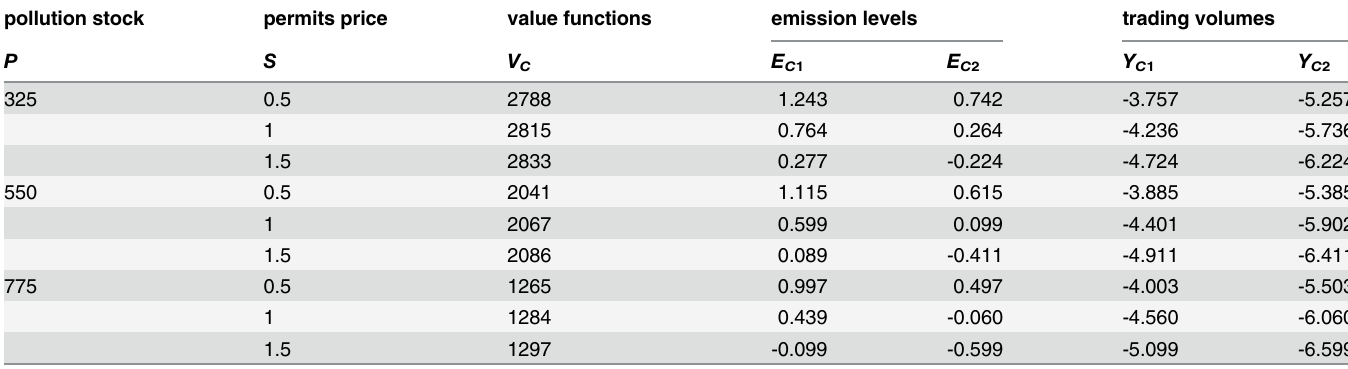
Table 4. The cooperative game at t = 5. pollution stock permits price value functions emission levels